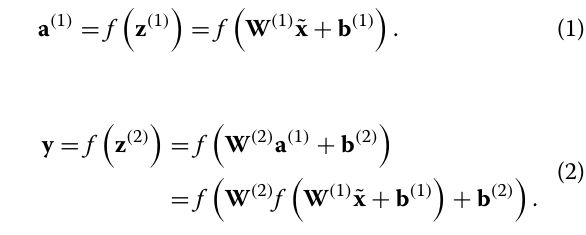
to the inputs of each successive layer. It is remarkable that the proposed model is robust to the input because it can reconstruct the original signals from the corrupted input. The proposed model extracts robust features by sparse penalty term, which punishes and inhibits the larger change in the hidden layer. In the corruption stage, the original signals are corrupted by additive white Gaussian noise ˜ x = x + λ n , where n denotes the additive Gaussian